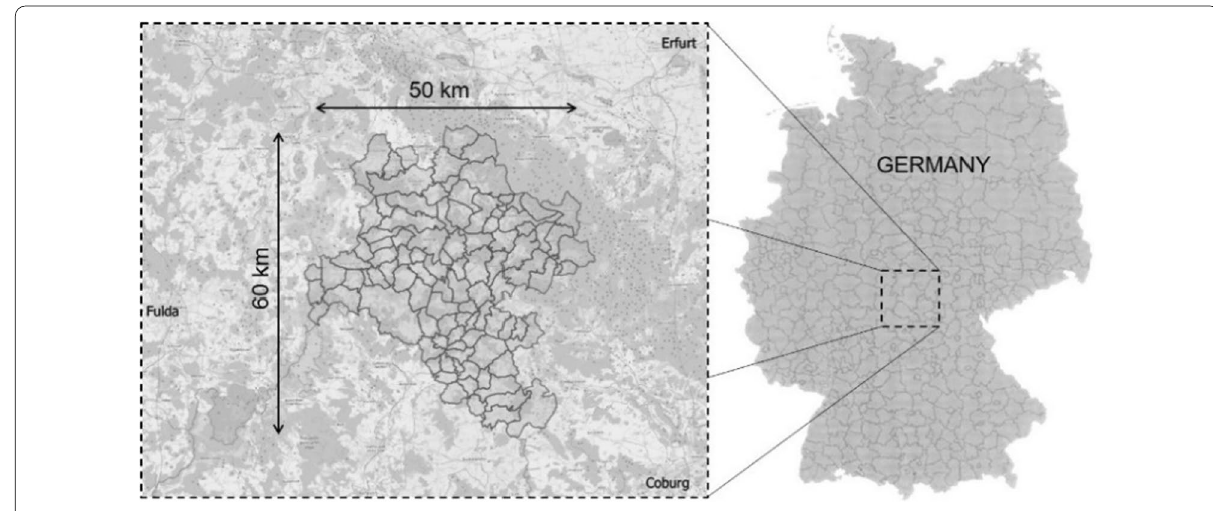
Fig. 3 Investigation area location and its subdivision by zonal system (cf.